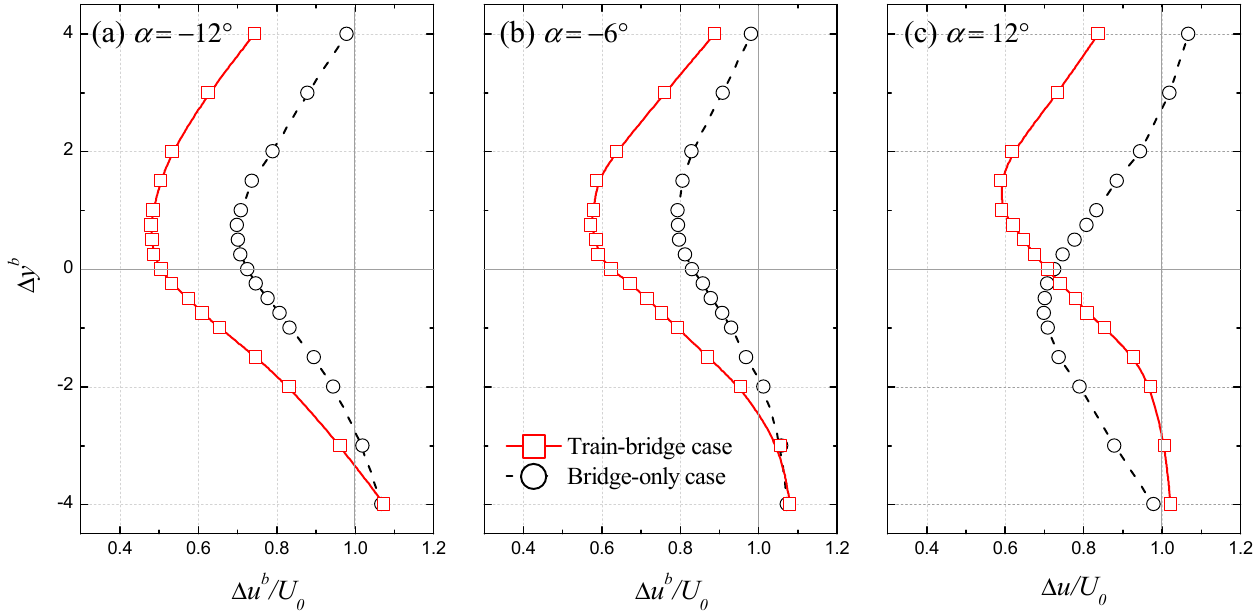
Figure 7. Wake profiles of the bridge-deck model at angles of a tt ack of − 12°, − 6°, and 12°.